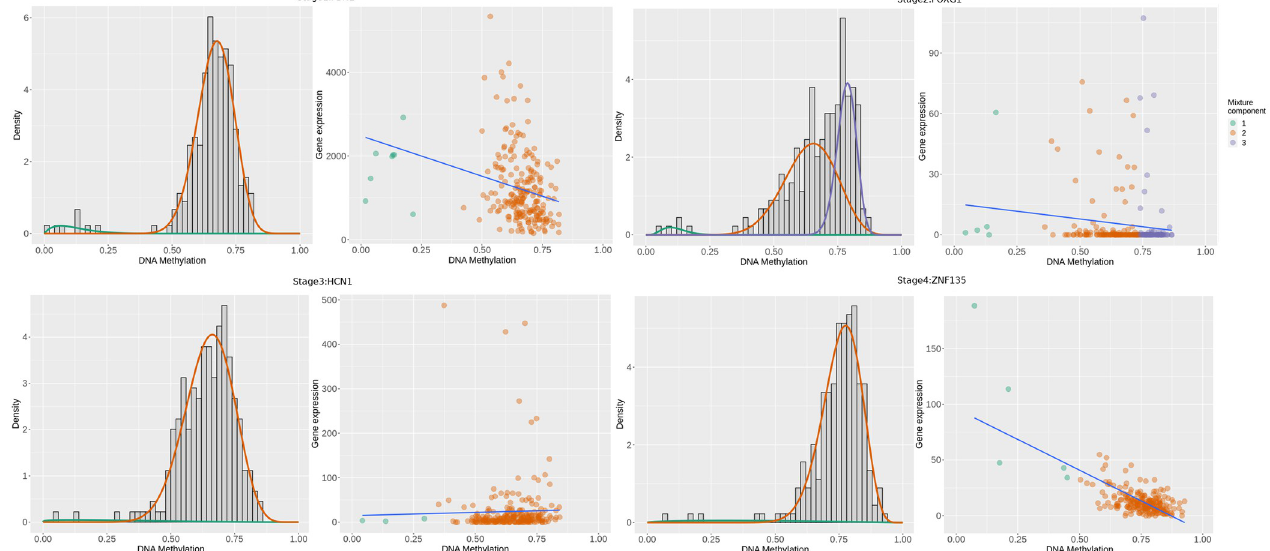
Fig 11. Mixture models and correlation plots of stage-salient genes. Shown are FBN1, FOXG1, HCN1, and ZNF135. Two mixture components are seen for FBN1, HCN1, and ZNF135, and three for FOXG1. A strong inverse correlation exists for all genes, except HCN1. Other stage-salient genes are shown in Fig 6.